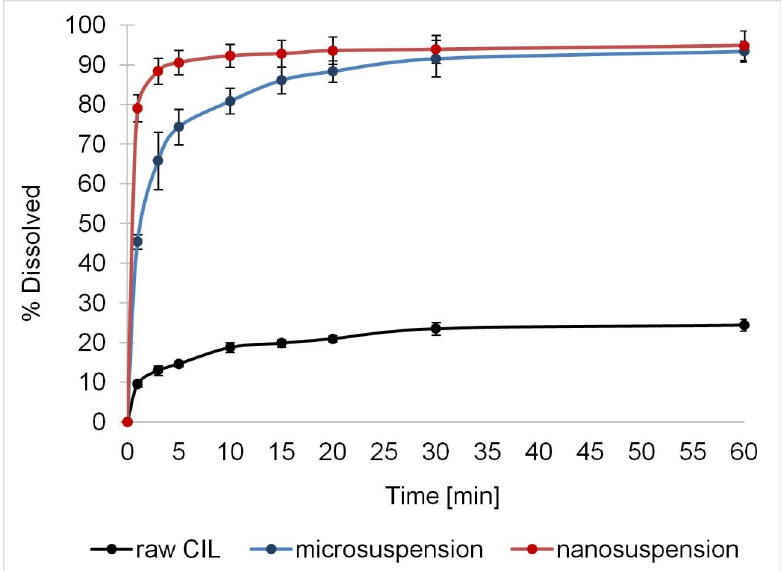
Figure 17. Dissolution profiles (mean ± SD) of unprocessed cilostazol (n = 6), microsuspension and nanosuspension (n = 7).